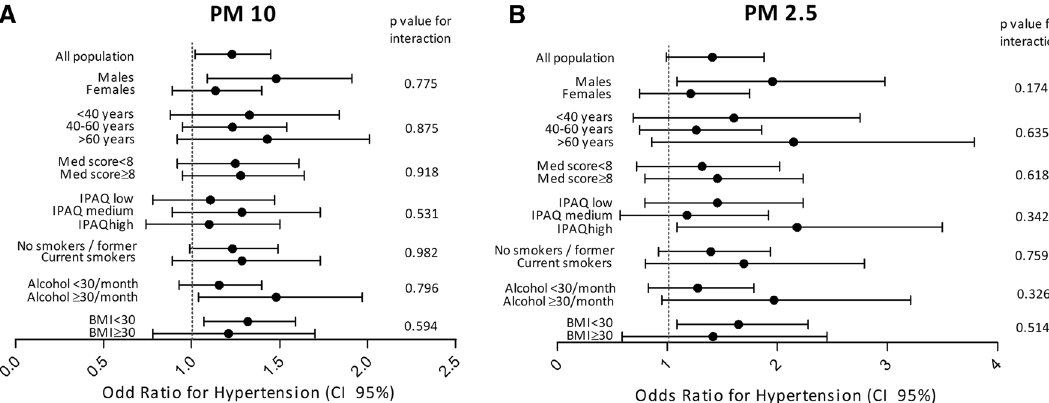
Figure 1. Association between PM 10 (1 A ) and PM 2.5 (1 B ) exposures and incident hypertension stratified by selected characteristics. Dots and bars are ORs and 95% CI for incident hypertension per 5 μg/m 3 increment of PM concentrations of PM 10 (1 A ) and PM 2.5 (1 B ) and NO2 (3 C ) derived from multiple logistic regression analyses. BMI, body mass index; CI, confidence interval; IPAQ, international physical activity questionnaire; MedScore, mediterranean diet score; PM, particulate matter; PM 10 , particles with an aerodynamic diameter of less than 10 µm; PM 2.5 , particles with an aerodynamic diameter of less than 2.5